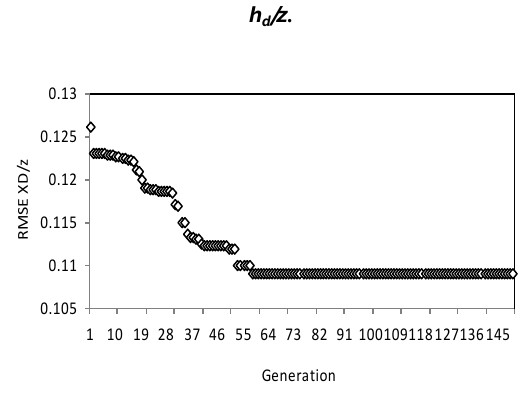
Figure 9. Comparison between observed and predicted GP to estimate h d /z .